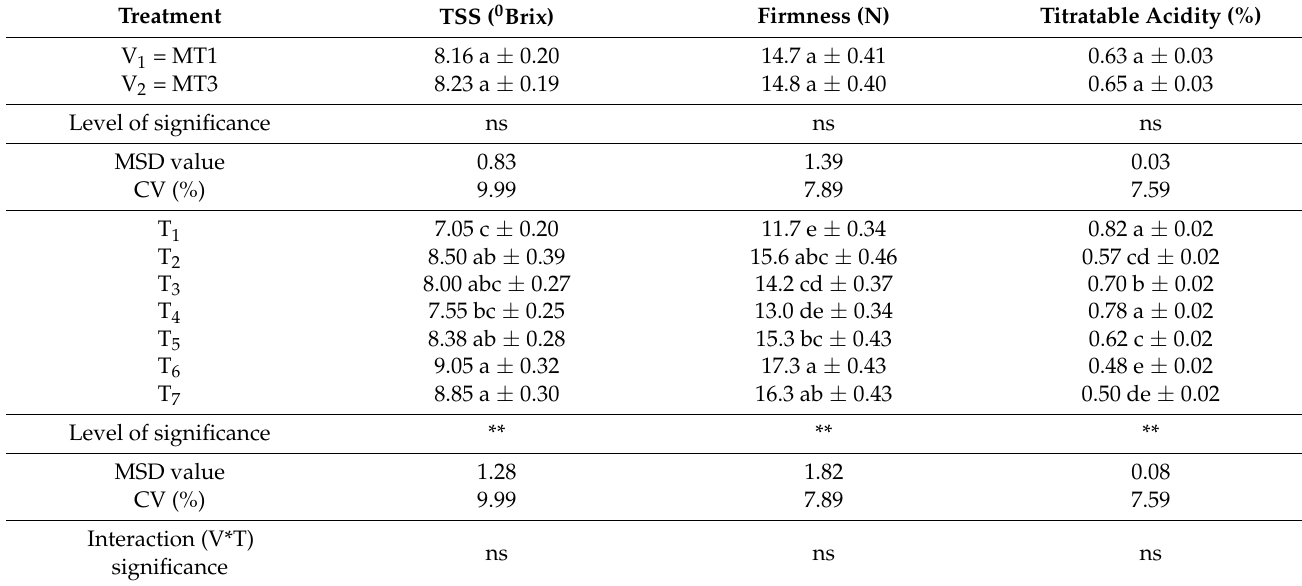
Table 5. Effect of zinc fertilizer and zinc oxide nanoparticles on total soluble solid, firmness, and titratable acidity of two selected tomatoes